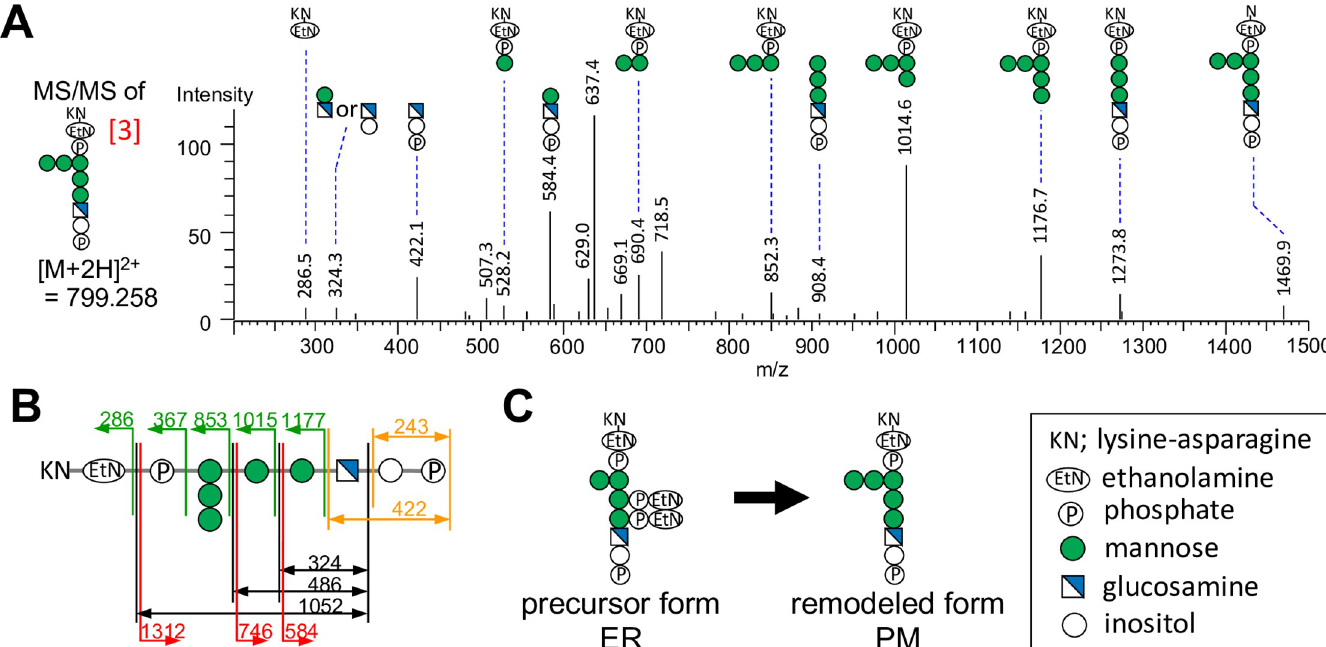
Fig 3. MS/MS analysis of remodeled GPI-glycan structure of Gas1-GFP. (A) MS/MS spectra of GPI glycan [3] found in Gas1-GFP immunoprecipitated from wild- type. Each fragment ions are shown with the deduced structures and the observed mass. (B) The theoretical fragmentation pattern of GPI glycan [3] found in Gas1-GFP immunoprecipitated from wild-type. The b-series fragments are indicated by green arrows, and the terminal and internal fragments of the GPI structure are indicated by red and black arrows, respectively. The orange arrows indicate m/z 422 and 243, a GPI-specific fragment ion treated with PI-PLC [6]. (C) Scheme of GPI glycan remodeling of Gas1-GFP. The remodeling of the GPI glycan during transport of Gas1-GFP from the ER to the plasma membrane (PM) involves the addition of a 5th Man on the 4th Man and the removal of the side-branch EtNP of Man1 and Man2.